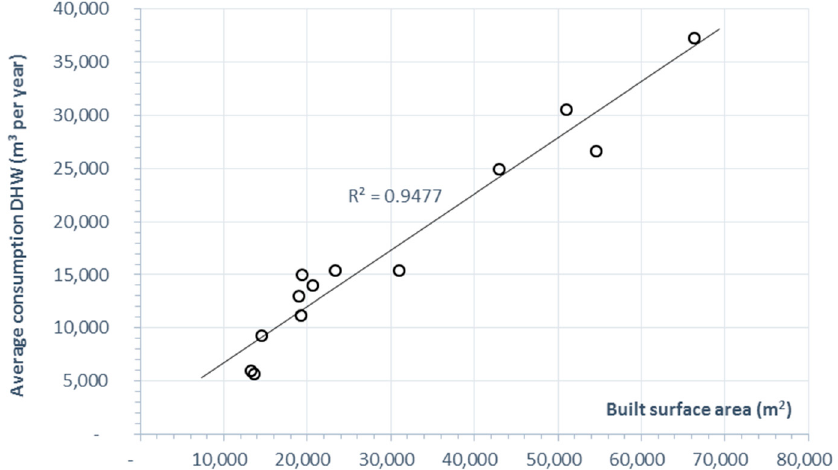
Figure 4. Relationship between the average annual consumption of domestic hot water and the built surface area per hospital.